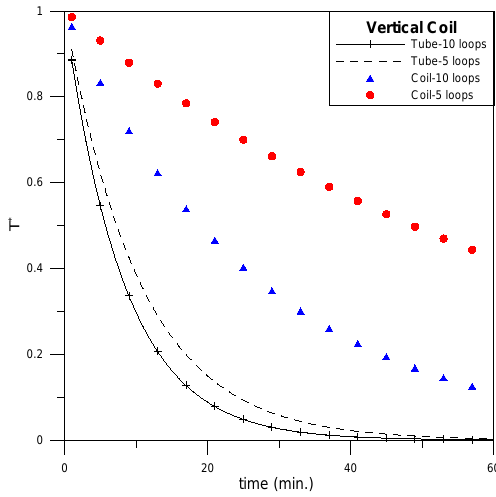
Figure 4. Efficiency variation of the coil with time.